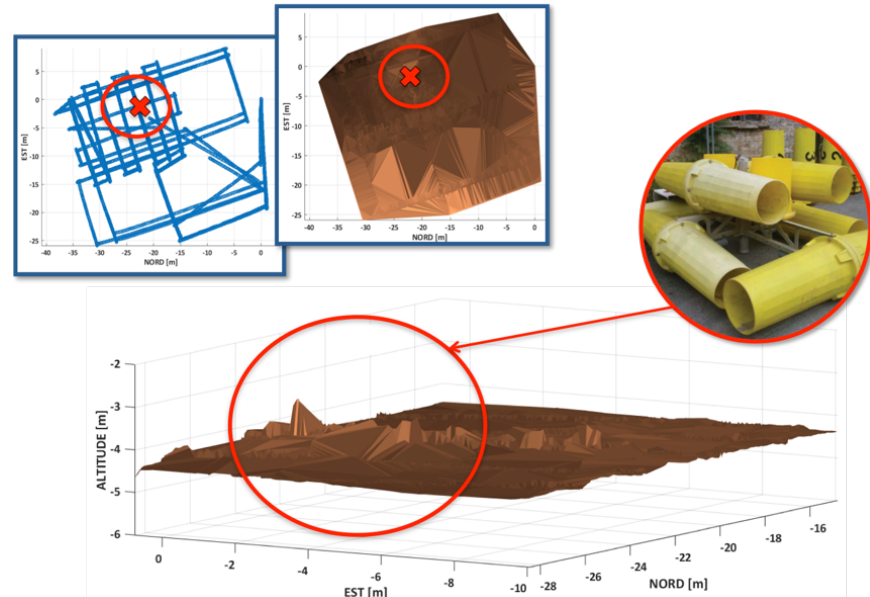
Figure 5. Localization of targets on the final 3D mesh